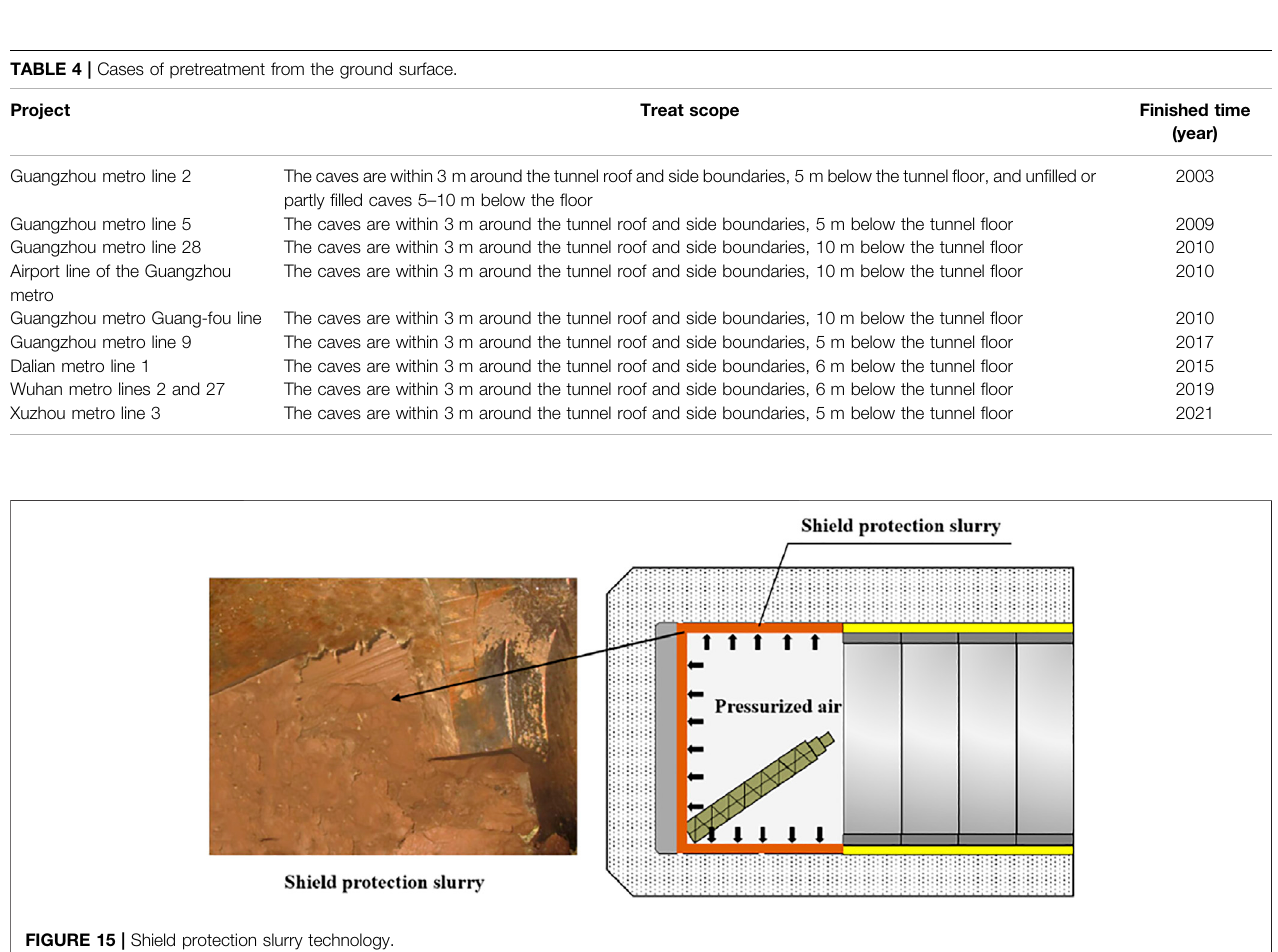
FIGURE 15 | Shield protection slurry